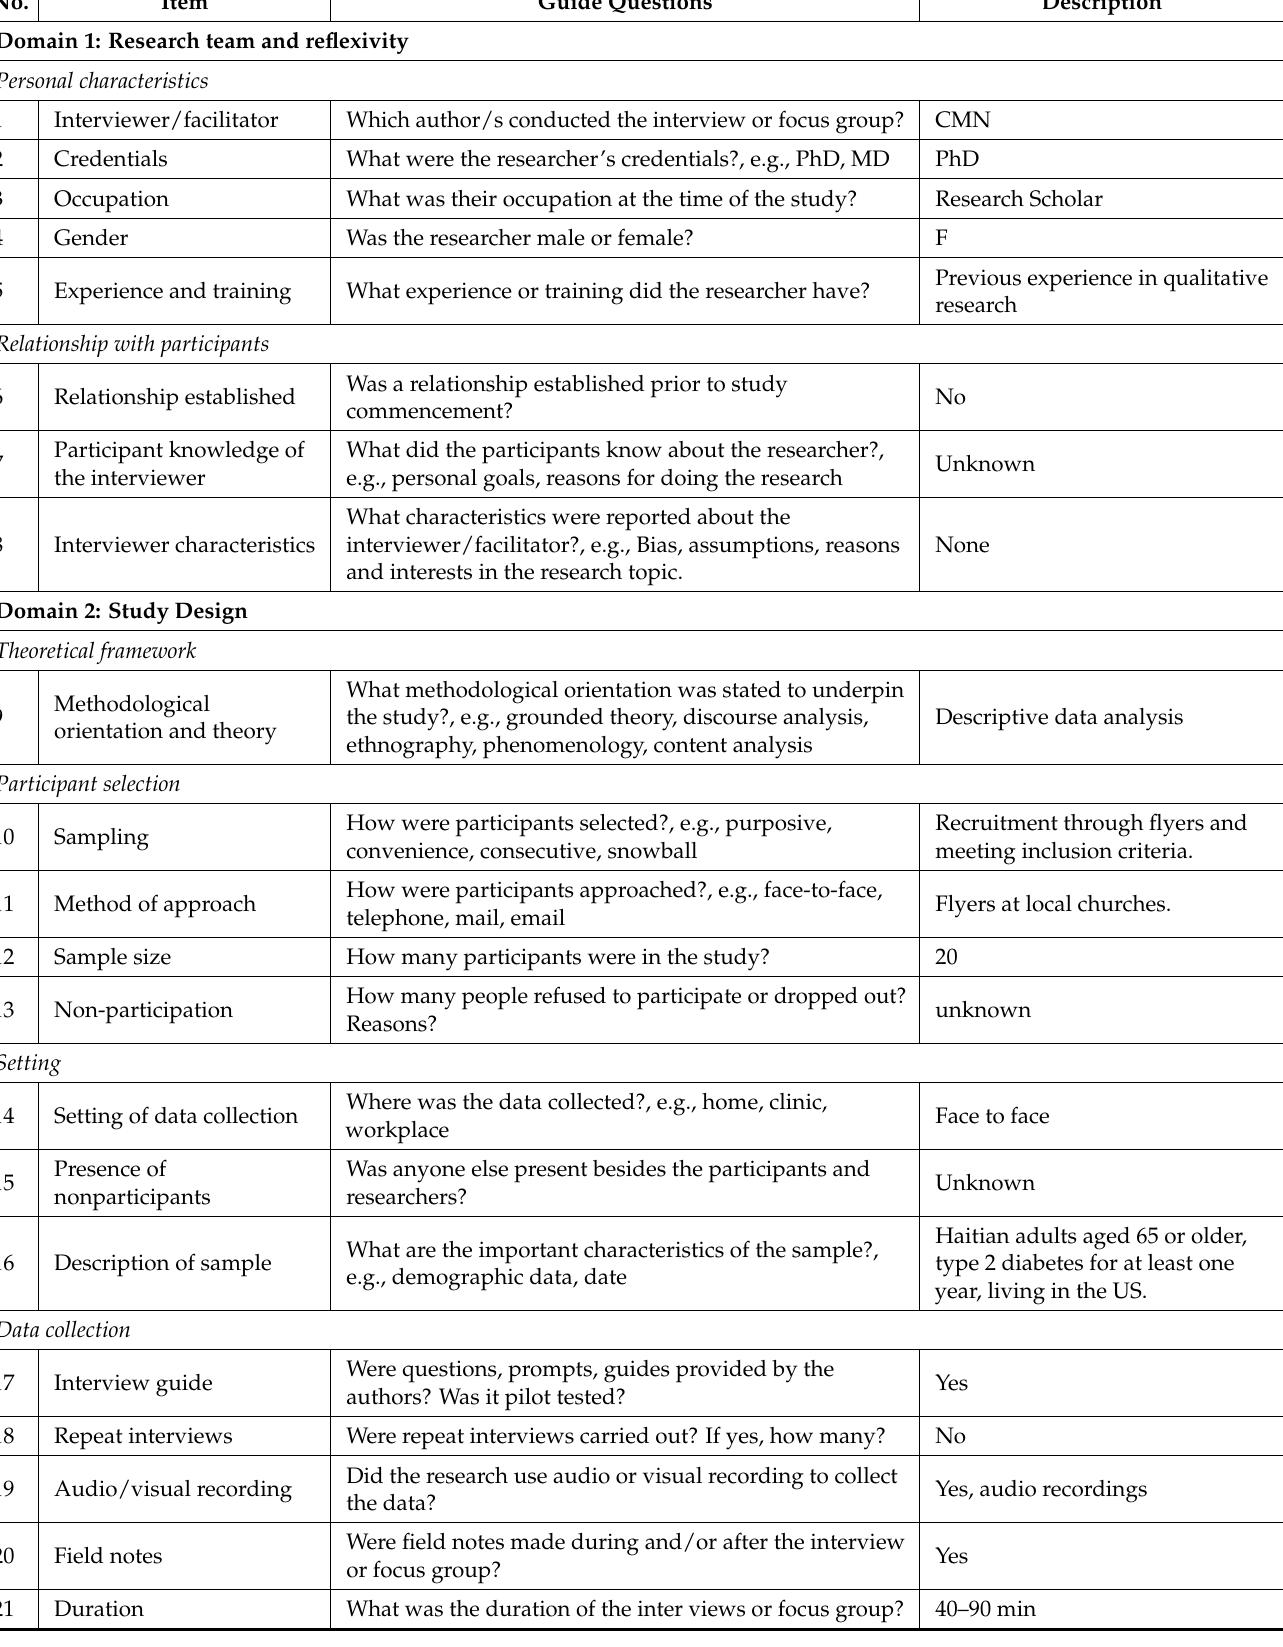
Table 3. Consolidated Criteria for Reporting Qualitative Research